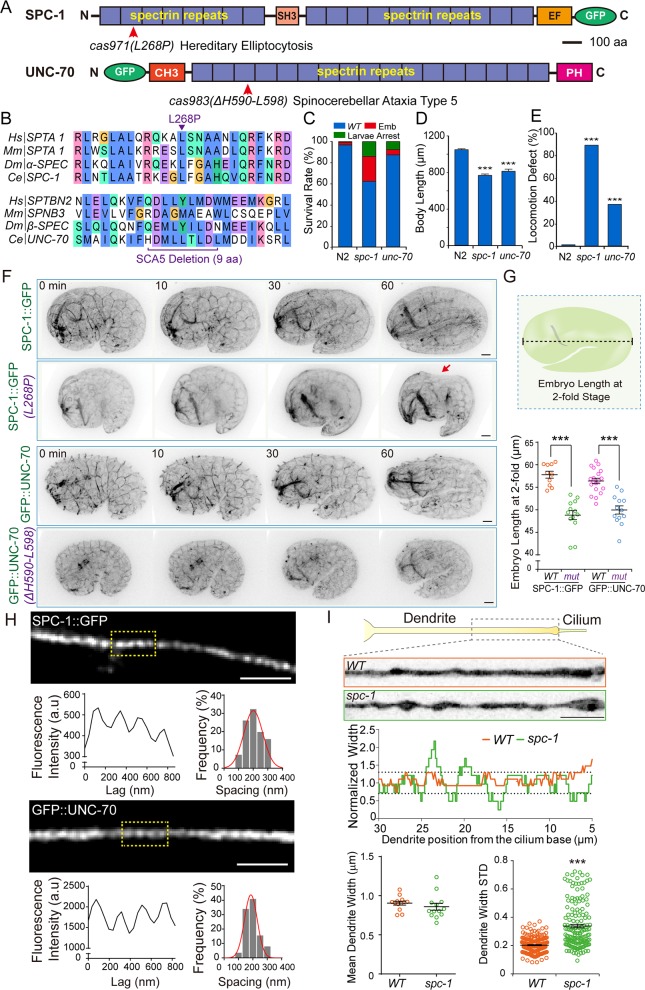
Disease-associated mutations in spectrin impair embryonic elongation and dendrite morphology.(A) Schematic protein domain structure of the C. elegans alpha-spectrin SPC-1 and beta-spectrin UNC-70. The CRISPR-Cas9–based homologous recombination strategy was used to introduce GFP into the C of SPC-1 or N of UNC-70. Human-diseases–associated mutations (arrows) were introduced into the WT N2 or the GFP KI SPC-1 or UNC-70 animals. Scale bar, 100 amino acids. (B) Alignment of sequences flanking the diseases-associated residue L268P in SPC-1 and an in-frame deletion removing H590-L598 in UNC-70. Both mutations are dominant in human diseases. The heterozygous C. elegans mutant animals harboring either spectrin mutation caused uncoordinated movement, and this study used homozygous animals for all the phenotype analyses. (C–E) Quantification of embryo survival rates (C), the animal body length (D), and locomotion defect (E) in WT (N2), spc-1 (cas971), and unc-70 (cas983) mutant animals from 3 generations. N = 50–100. Error bars are SEM. Comparisons were performed between the WT and mutants, ***p < 0.001. (F–G) Fluorescence inverted images from time-lapse spinning disk confocal movies of SPC-1::GFP, SPC-1 (L260P)::GFP, GFP::UNC-70, and GFP::UNC-70 (SCA5-del) embryos. 0 min, the comma stage; 60 min, the 2-fold stage of WT embryos. The red arrow indicates the deformed dorsal region of the spc-1 mutant embryo. Embryo lengths are the distance from the embryo head to the tail. (G) Scale bar, 5 μm; comparisons were between the WT and mutants, ***p < 0.001. (H) Representative images of SPC-1::GFP (upper) or GFP::UNC-70 (lower) in neuronal processes of motor neurons in live C. elegans at the young-adult stage. The low magnification views are in S2C and S2D Fig. The corresponding fluorescence intensity of the boxed region, left; and the histogram of the spacings between periodic structure, right; N = 100–150. The red line is a Gaussian fit. Scale bar, 1 μm. (I, upper) A model of the dendrite and cilium in a ciliated sensory neuron of the young-adult C. elegans (top). A representative image of the boxed region was visualized using a red fluorescent protein Scarlet tagged with a myristoylation signal in WT (middle) and spc-1 (cas971) mutant (bottom) animals. (Middle) Plots of the normalized width along the representative dendrites within 5 to 30 μm from the ciliary base. (Lower) Quantification of the dendrite width and the width SD at each pixel within 5 to 30 μm from the ciliary base in WT or spc-1 mutant animals. Scale bar, 5 μm. Comparisons were between the WT and mutants, **p < 0.01, ***p < 0.001. Data associated with this figure can be found in S1 Data. a.u, arbitrary unit; C, C terminus; CH3, calponin homology domains type 3; CRISPR-Cas9, clustered regularly interspaced short palindromic repeats-Cas9; EF, EF-hand calcium-binding motifs; Emb, embryo; GFP, green fluorescence protein; KI, knock-in; N, N terminus; PH, Pleckstrin homology domain; SCA-5, spinocerebellar ataxia type 5; SH3, Src homology domain 3; WT, wild type.